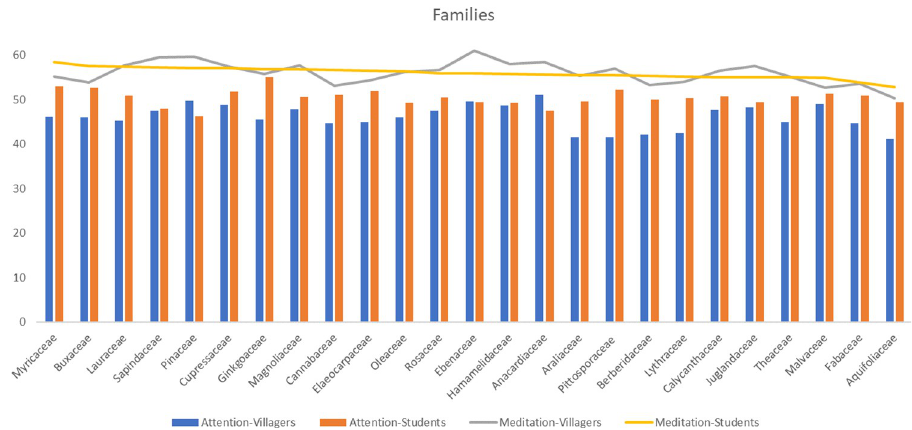
Fig 10. The average value of EEG indicators of villagers and students in different